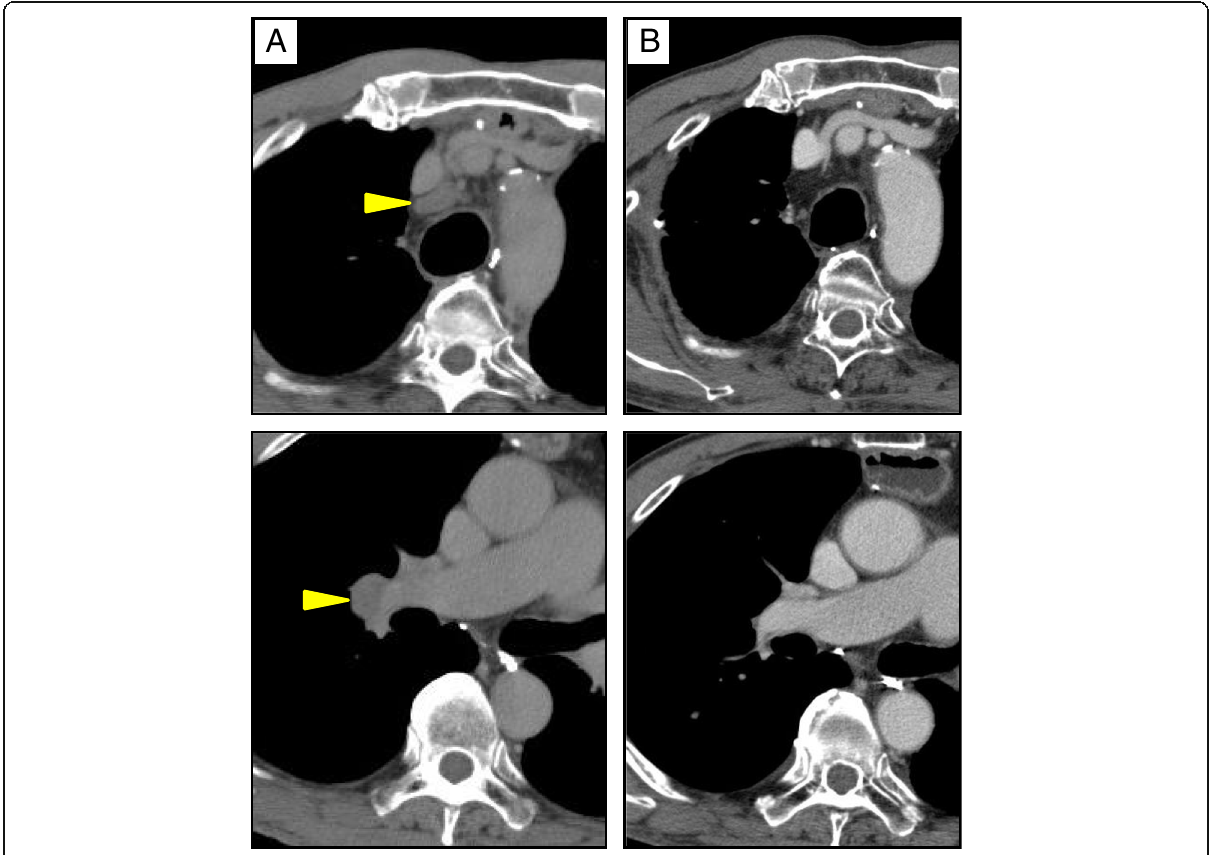
Fig. 6 CT images showing LN metastases at mediastinum and hilum. a Before chemotherapy (arrowheads). b After treatment (the LNs have